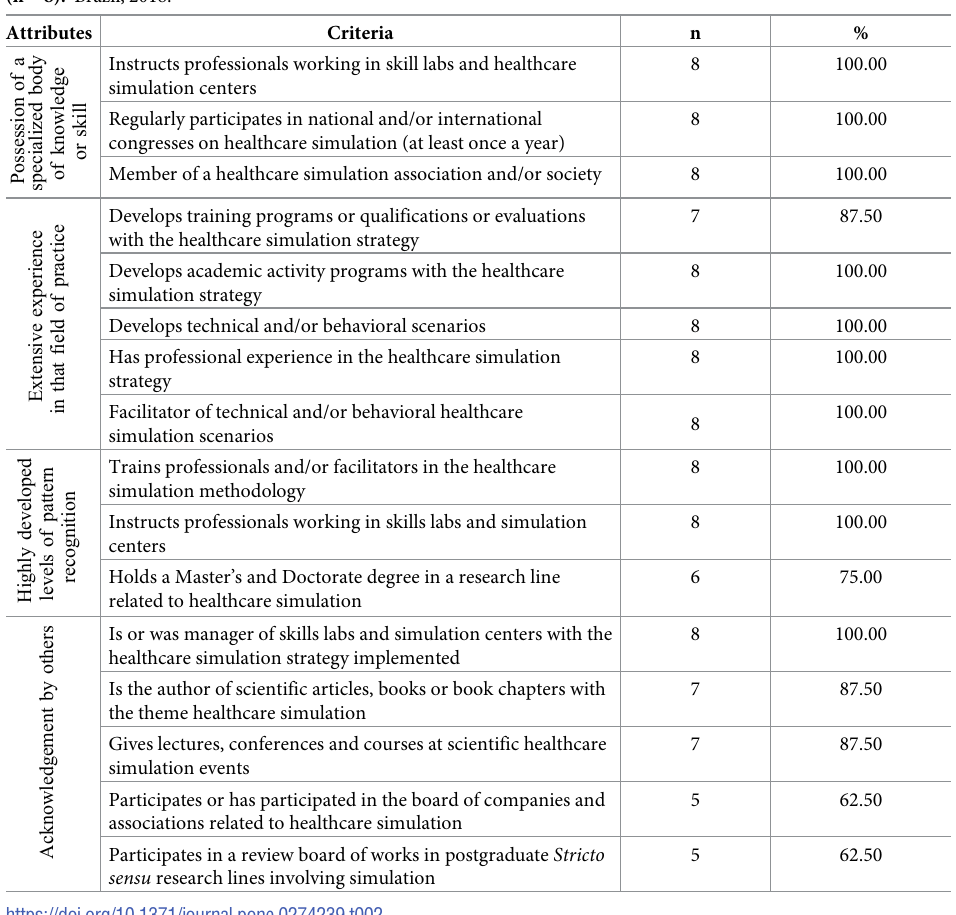
Table 2. Selection of experts according to the attributes proposed by Jasper [33] and modified for this study (n = 8). Brazil,